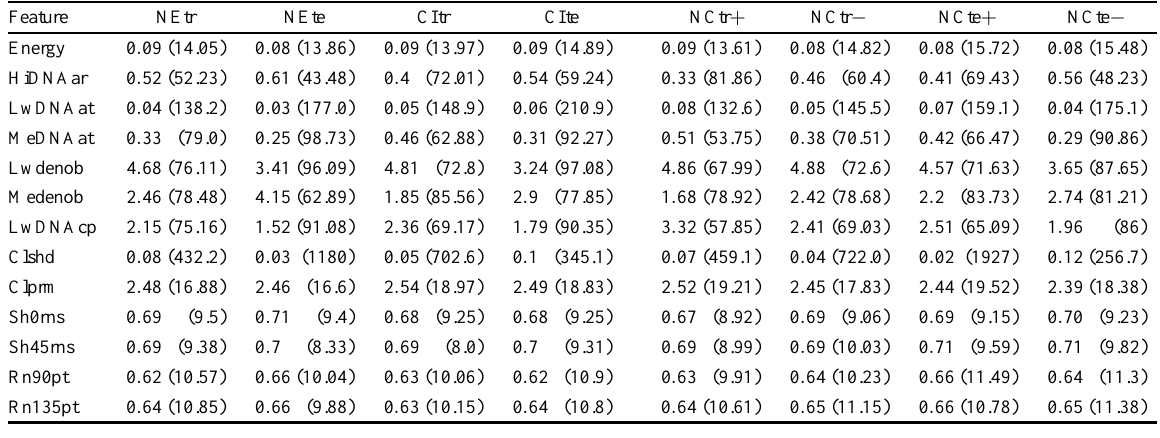
Group mean values and coefficients of variation (%) of features selected by classifier 1 or 2